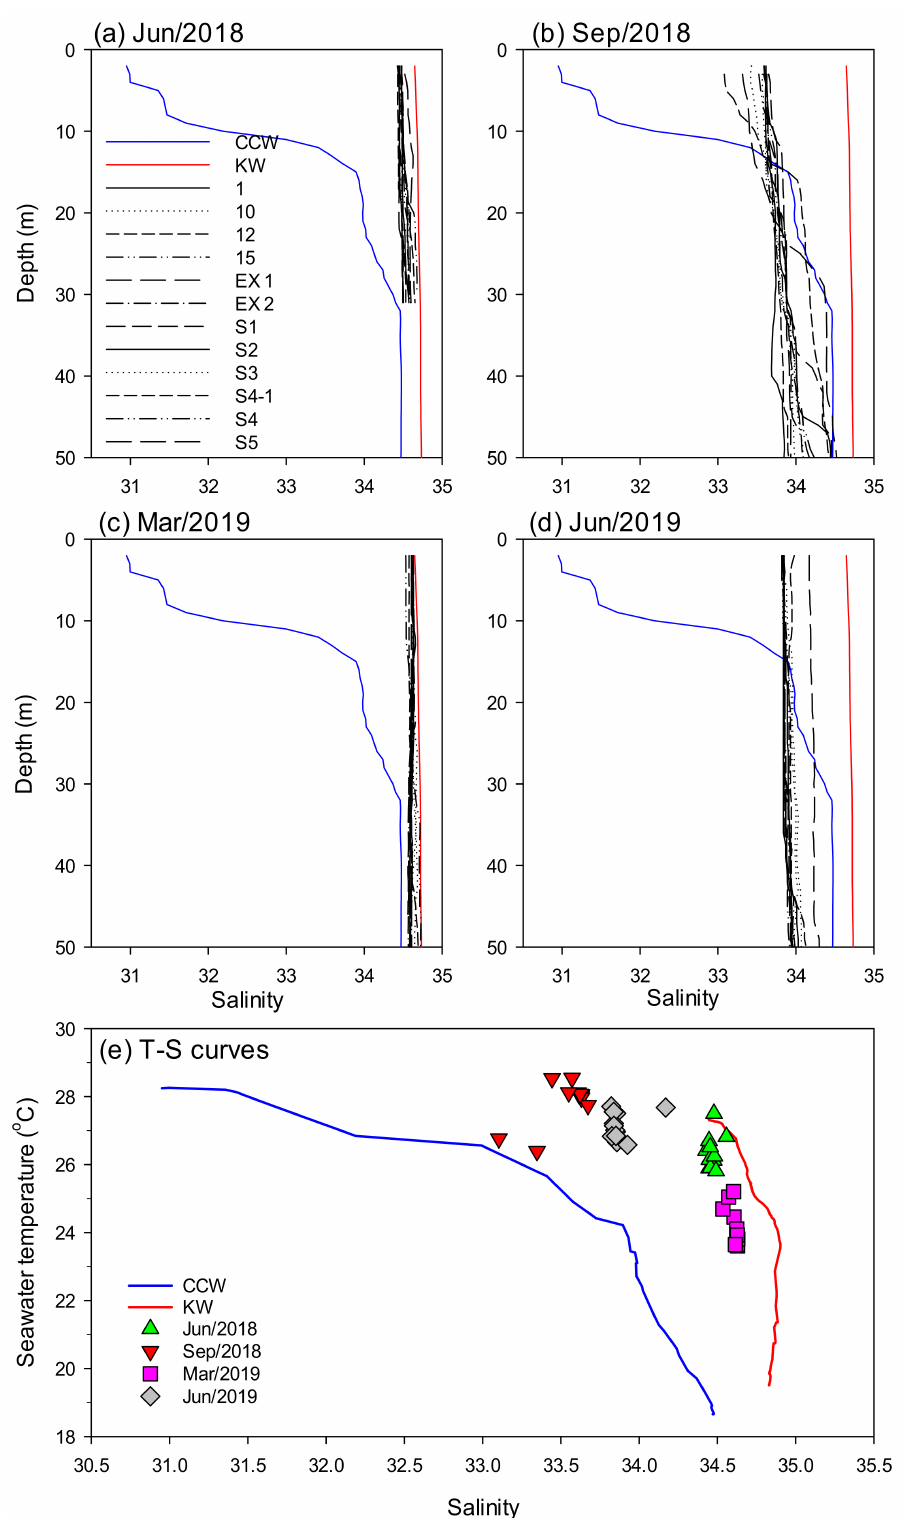
Figure 2. Salinity profile above 50 meters depth recorded at each sampling station. Data referred to 2018 in June (above 30 m depth) ( a ), September ( b ); and 2019 in March ( c ), June ( d ). The temperature (T) and salinity (S) diagram shows the distribution of averaged values of surface water (above the 10 m depth) of each sampling stations during all cruises ( e ). Two reference temperature–salinity curves were recorded from cruise OR1 618 between 15 July and 29 July 2001; the blue and red solid lines of T-S curves indicating the CCW (plume of Yangtze River; 30 ◦ 30 (cid:48) N 122 ◦ 52 (cid:48) E) and KW (Kuroshio water; 25 ◦ 10 (cid:48) N 123 ◦ 10 (cid:48) E) (adopted from Tseng et al. [30]),